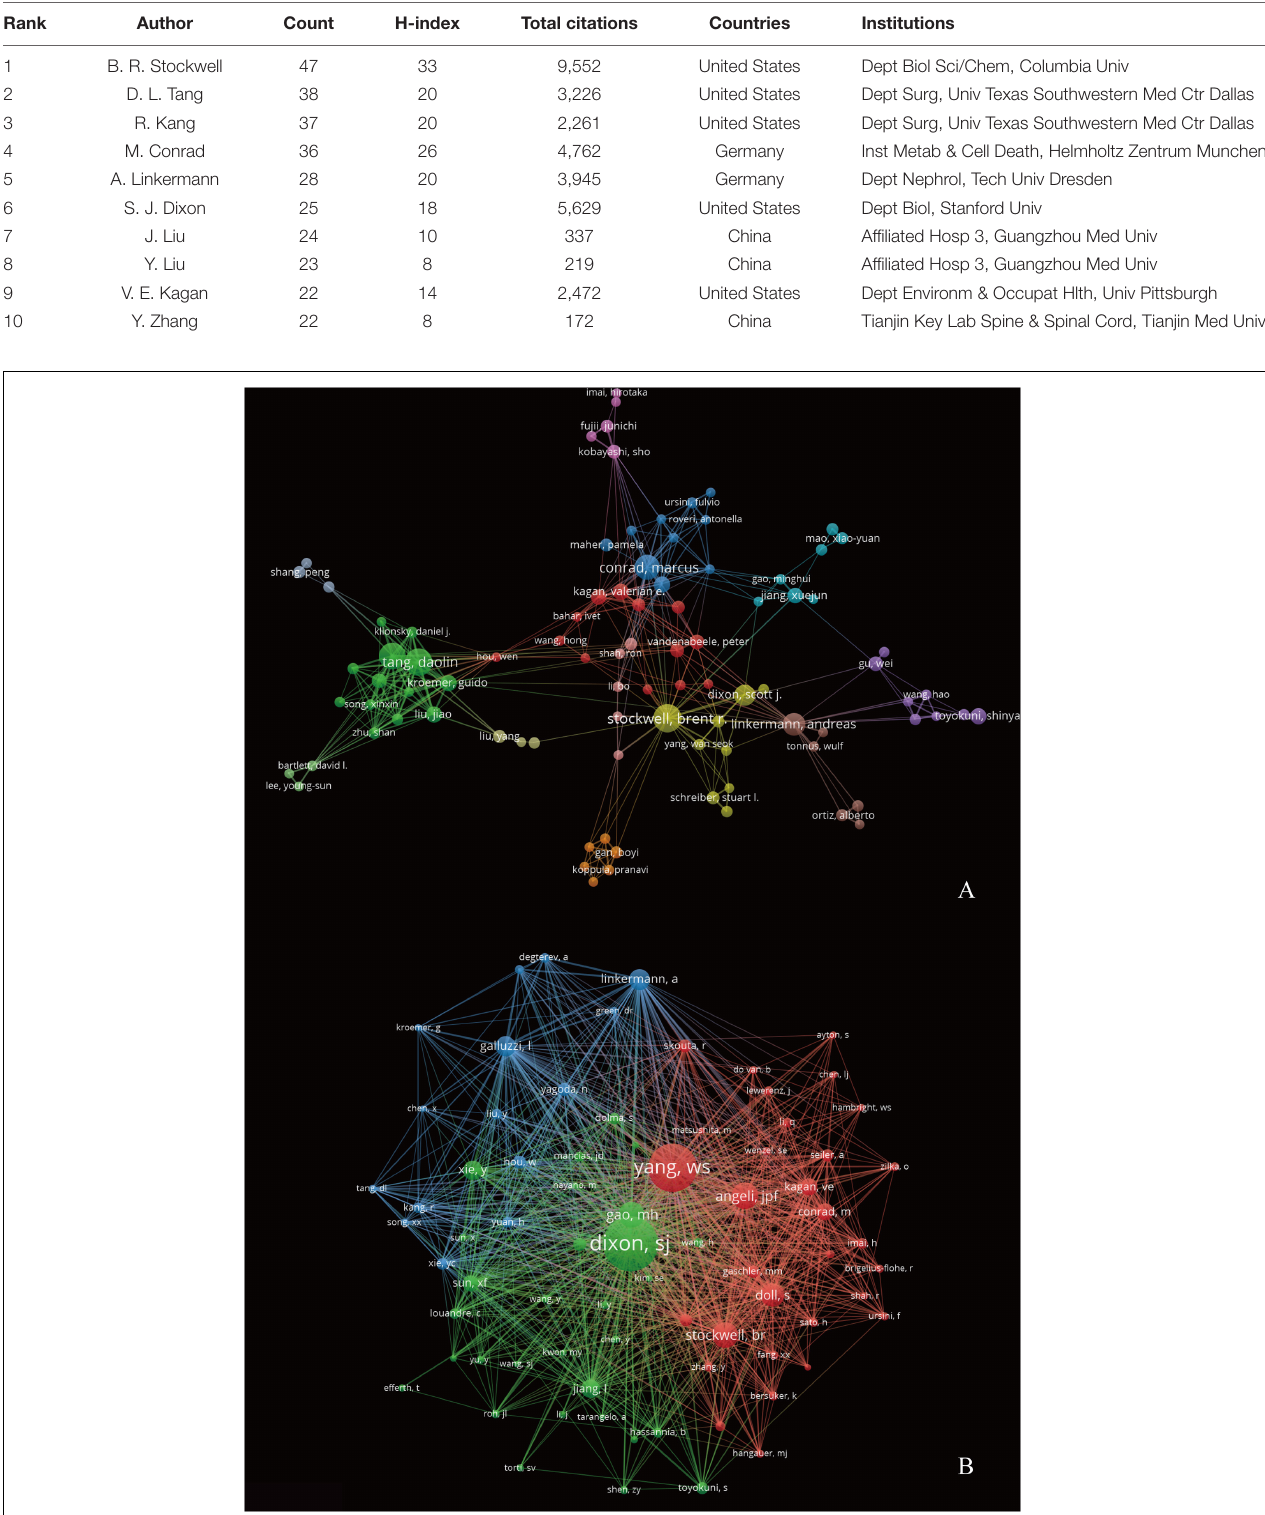
TABLE 3 | The top 10 most productive authors in ferroptosis publications.